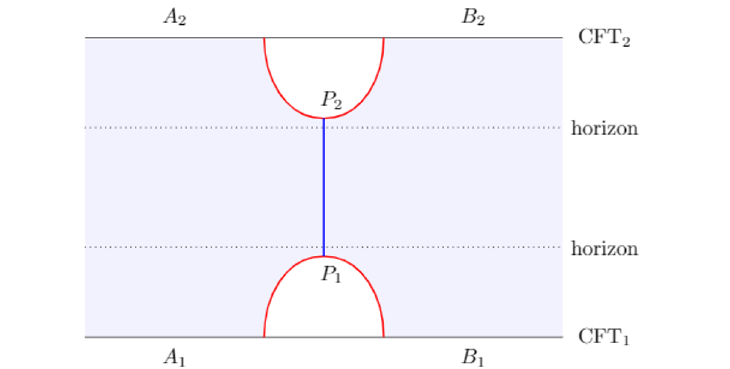
Figure 2 . The pictorial representation of the second possibility of the HRT surfaces corresponding to region A [ B . We referred to these surfaces as con(cid:12)guration-2. The HRT surfaces (shown as red curves) in this con(cid:12)guration is the union of two surfaces, both of which remain in the asymptotic regions. As a result, the entanglement wedge (shaded region) in this con(cid:12)guration is connected. The blue surface is the cross-section of the entanglement